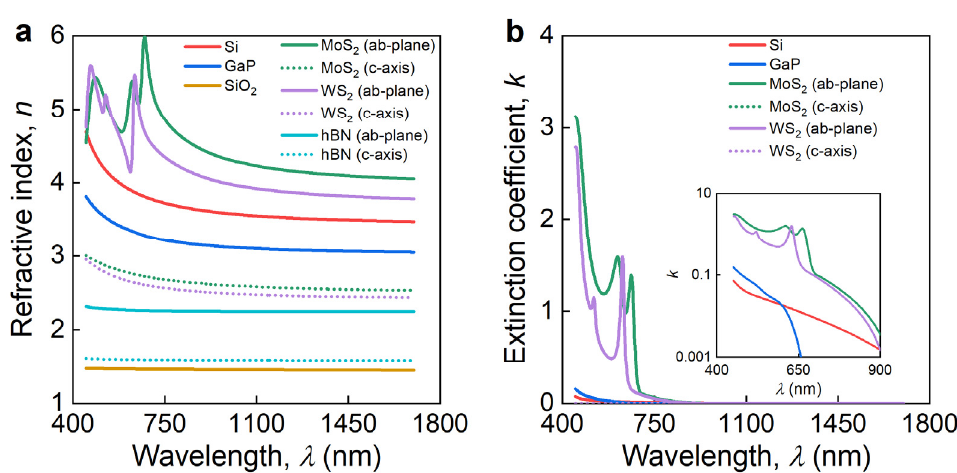
Figure A1. Optical constants of Si, GaP, SiO 2 , MoS 2 , WS 2 , and hBN, used in the work. ( a ) Refractive index and ( b ) extinction coefficient. The inset shows extinction coefficient in logarithmic scale.